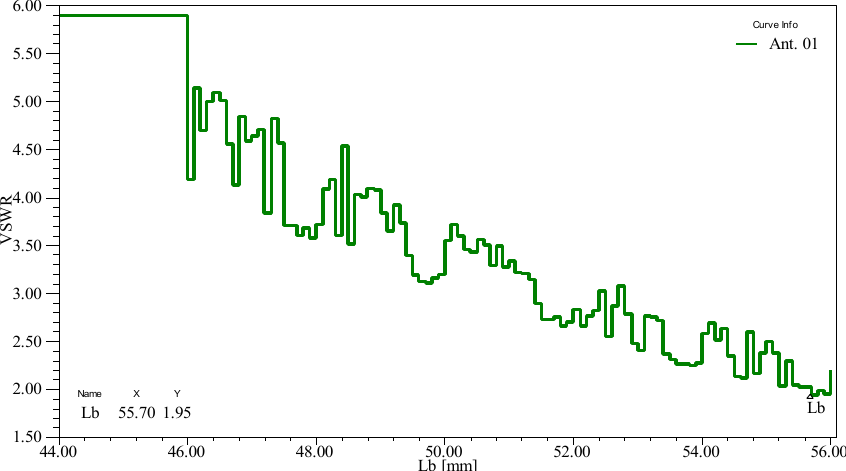
Figure 6. VSWR (Voltage Standing Wave Ratio) of Slot antenna 1 at 2450 MHz versus Lb (mm).